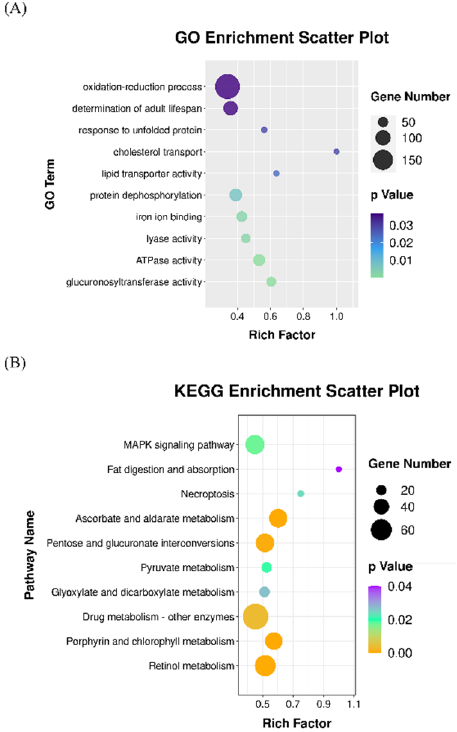
Figure 5. Integrant enrichment of GO terms ( A ) and KEGG pathways ( B ) of the target genes of the differentially expressed miRNA in C. elegans treated with astaxanthin. Rich factor is the ratio of DEG number in each group to the total number of genes identified in the GO or KEGG analyses.